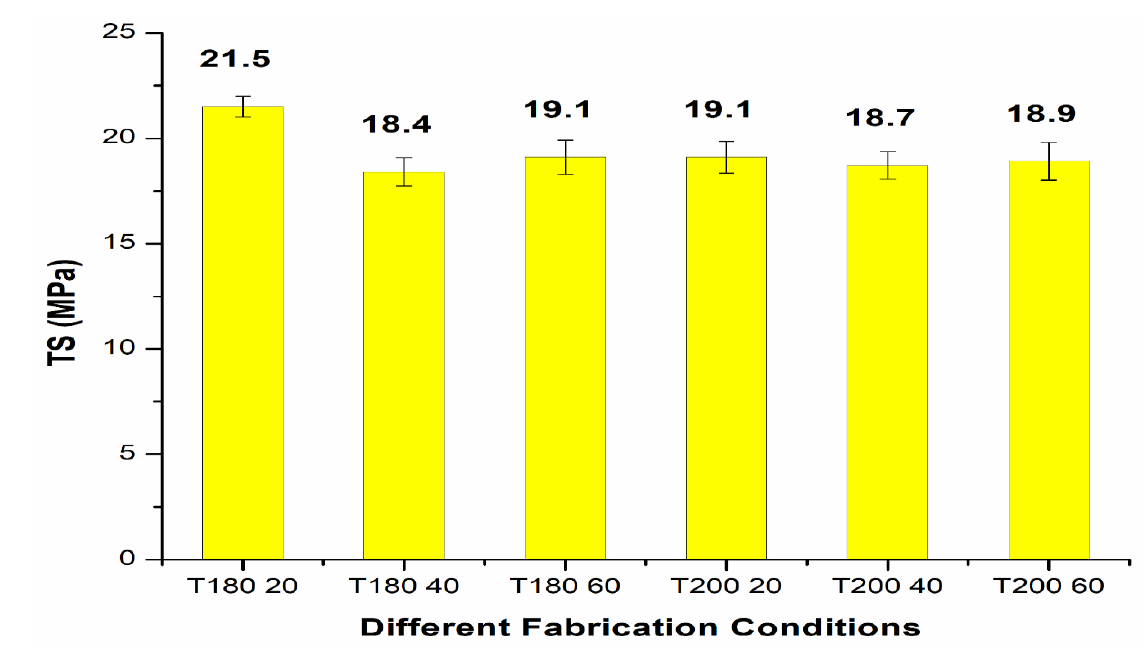
Figure 9. Tensile strength (TS) of 10 wt.% CF/plasma PE under different fabrication conditions.